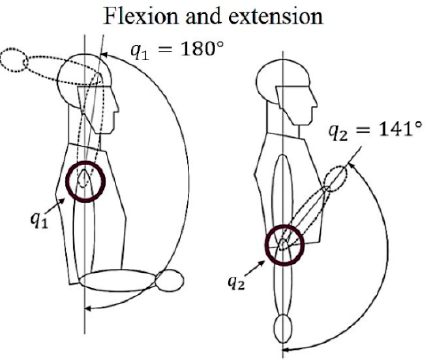
Figure 1. Model of the human arm and elbow joints during flexion and extension movements.